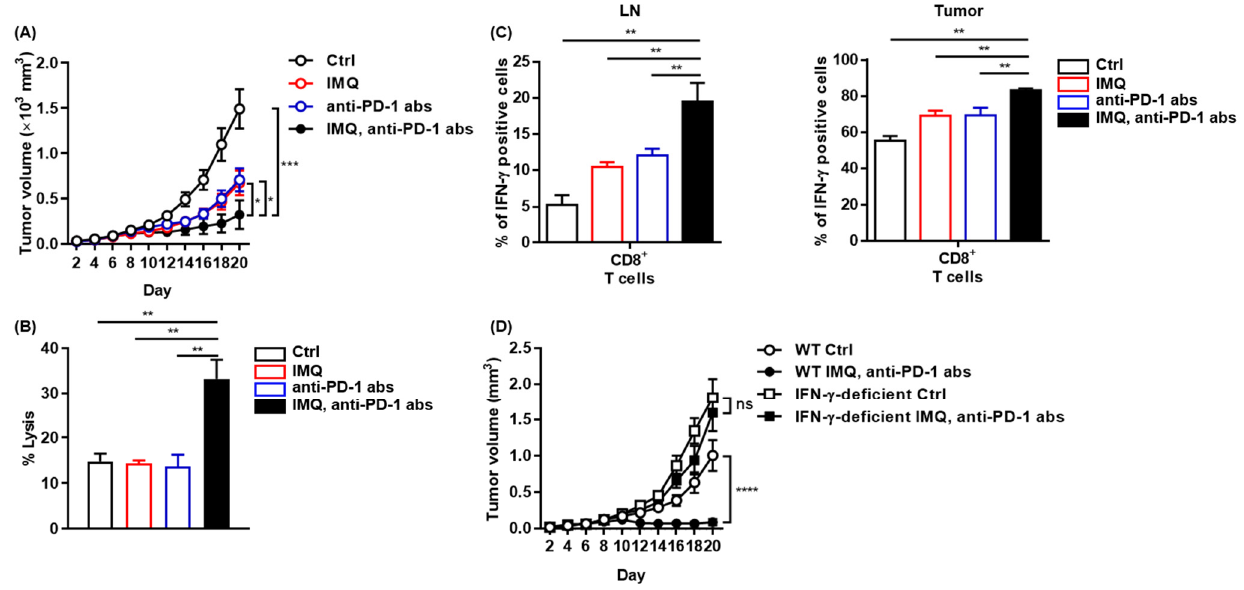
Figure 7. Potent antitumor effect of combination therapy of topical IMQ with anti-PD-1 antibody. ( A ) Time course of the tumor volume after 2 × 10 6 MC38 colon cancer cells were intradermally inoculated into the backs of wildtype mice with topical IMQ application, anti-PD-1 antibody treatment, topical IMQ plus anti-PD-1 antibody treatment, or no treatment ( n = 12 in each group). ( B ) Percentage killing of MC38 colon cancer cells by immune cells from LNs 9 days after the inoculation of MC38 colon cancer cells into wildtype mice with topical IMQ application, anti-PD-1 antibody treatment, topical IMQ plus anti-PD-1 antibody treatment, or no treatment ( n = 6 in each group). ( C ) Flow cytometric analysis of IFN- γ expression in CD8 + T cells in lymph nodes and tumors 10 days after tumor inoculation with topical IMQ application and anti-PD-1 antibody administration at day 8 ( n = 5 in each group). ( D ) Time course of the tumor volume after 2 × 10 6 MC38 colon cancer cells were intradermally inoculated into the backs of wildtype mice with topical IMQ monotherapy, anti-PD-1 antibody monotherapy, topical IMQ application plus anti-PD-1 antibody treatment, or no treatment ( n = 11 in wildtype mice with no treatment, n = 10 in wildtype mice with IMQ application plus anti-PD-1 antibody treatment or IFN- γ -deficient mice with IMQ application with anti-PD-1 antibody treatment or no treatment). WT: wildtype, Ctrl: control, IMQ: imiquimod, LNs: lymph nodes, IFN- γ : interferon γ , abs: antibodies, ns: not significant. Error bars indicate ±1 SEM; * p < 0.05, ** p < 0.01, *** p < 0.001, **** p < 0.0001.